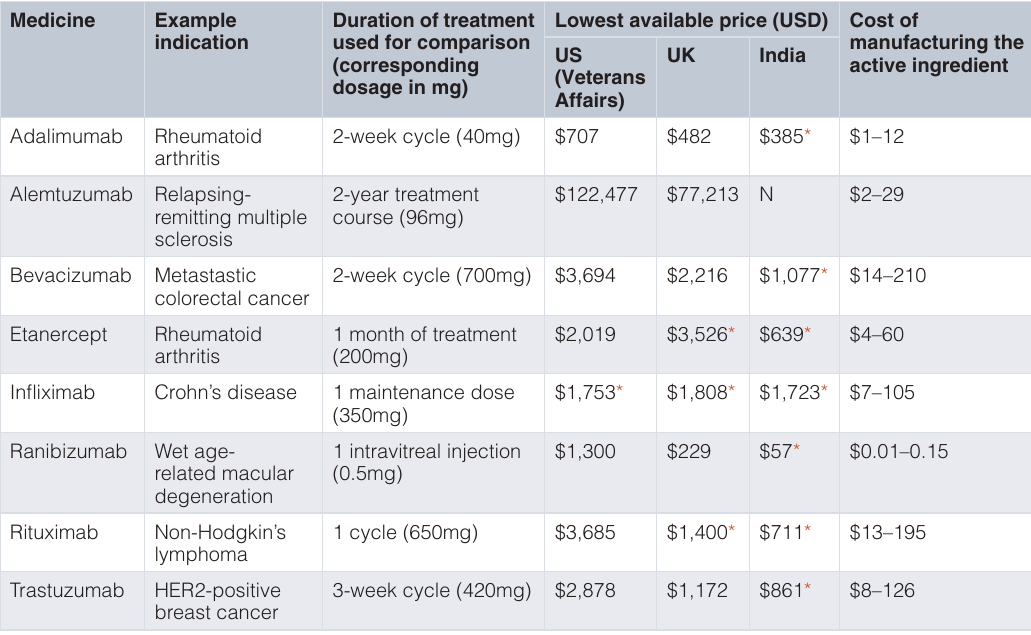
Table 1. Current prices of selected blockbuster biologics and cost of manufacture for the active ingredient. The table illustrates the large differences between current prices and the cost of manufacturing the active ingredient, for blockbuster biologic